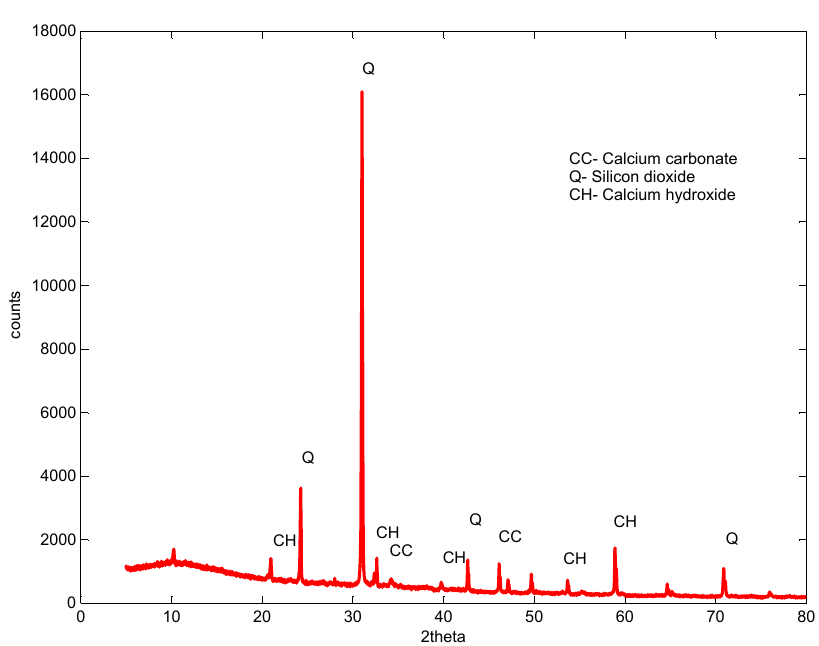
Figure 12. One percent dosage XRD sample at 56 days w/b =